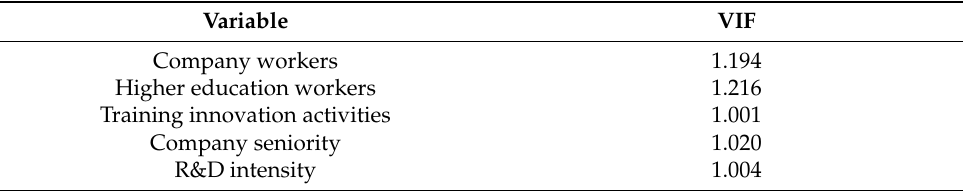
Table 3. VIF Factor (variance inflation factor).